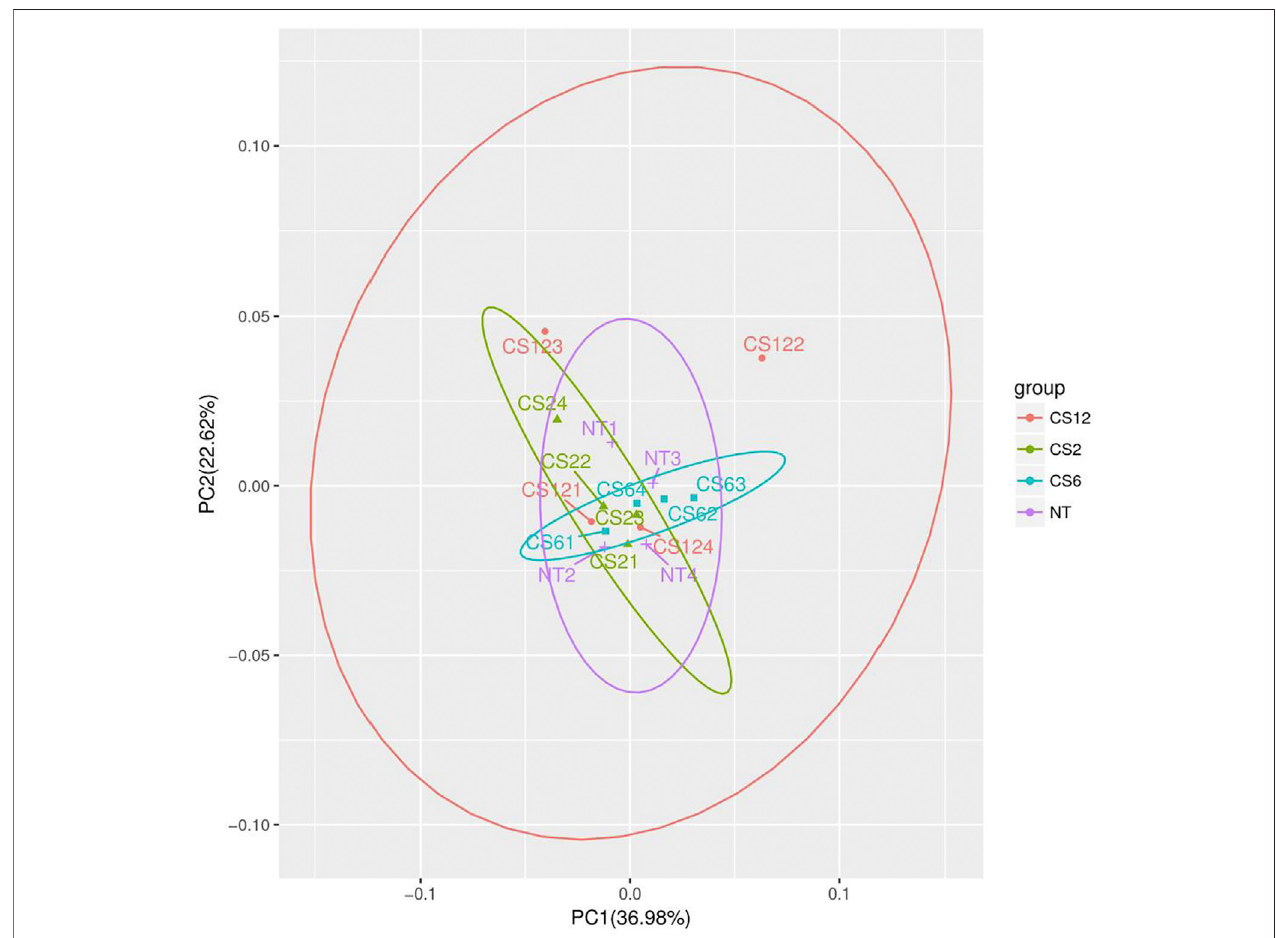
FIGURE1| PCAscoreplotsofdifferentcoldexposuredurationgroups.Note:NT=normaltemperaturegroup(24±2 ° C),CS2=coldexposure(4±2 ° C)2-hourgroup, CS6=coldexposure6-hourgroup,andCS12=coldexposure12-hourgroup;NT1~4inthe fi gurecorrespondedtothefoursamplesoftheNTgroup(24±2 ° C),similarto the CS2, CS6, and CS12